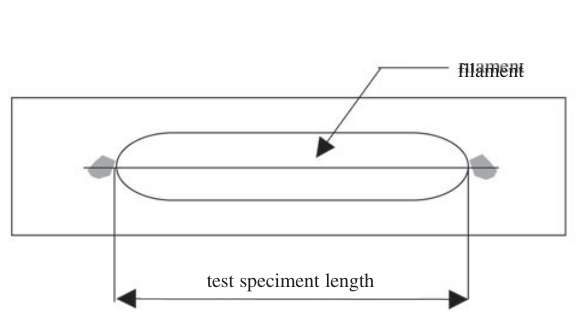
Figure 1. Support tab for testing fibre filaments according to ASTM D 3379M 1 .